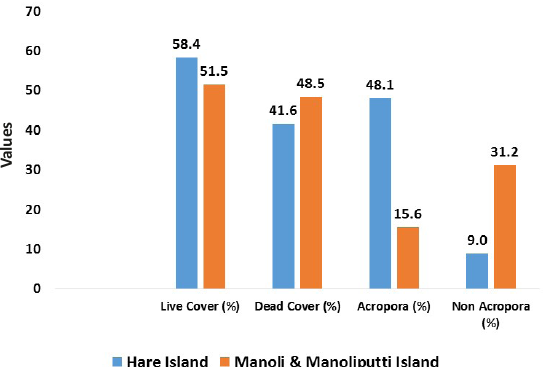
Figure 1. Average live coral coverage of Hare and Manoli & Manoliputti